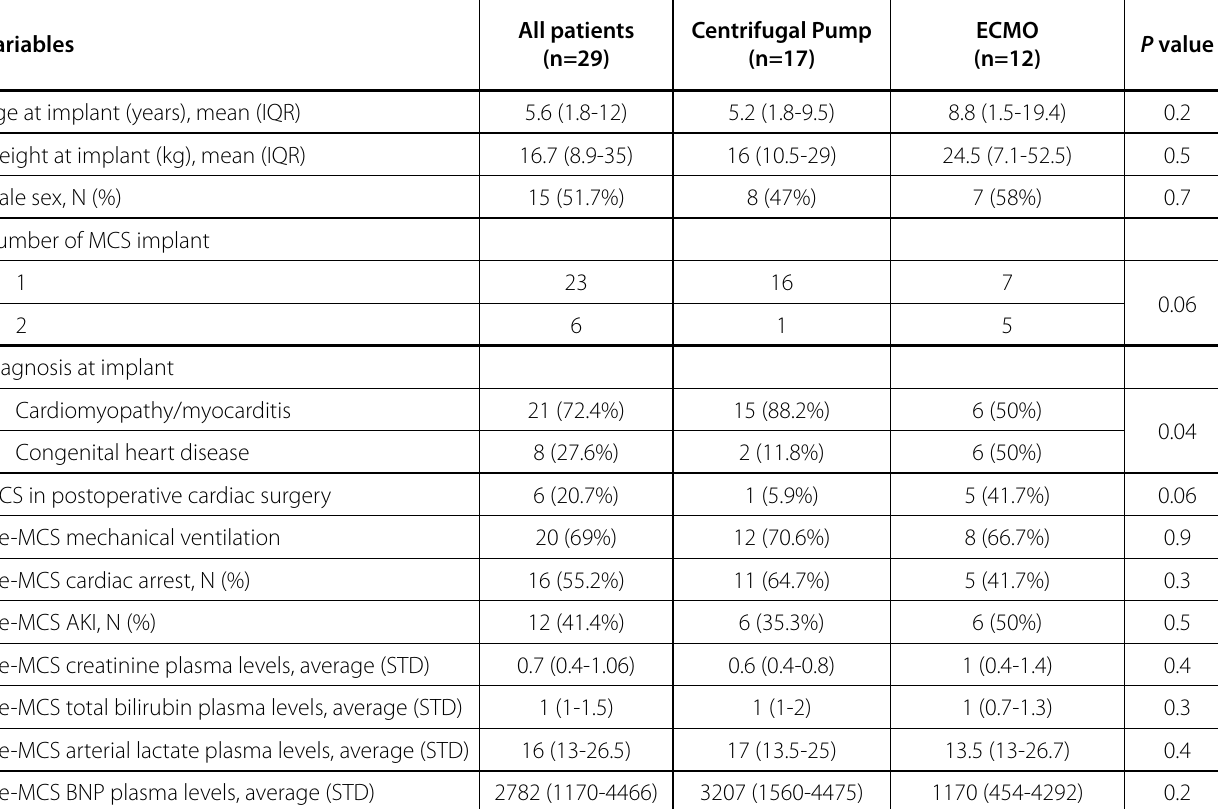
Table 1 . Pediatric and congenital heart transplant patients receiving mechanical circulatory support demographics comparing centrifugal pump and ECMO patients.